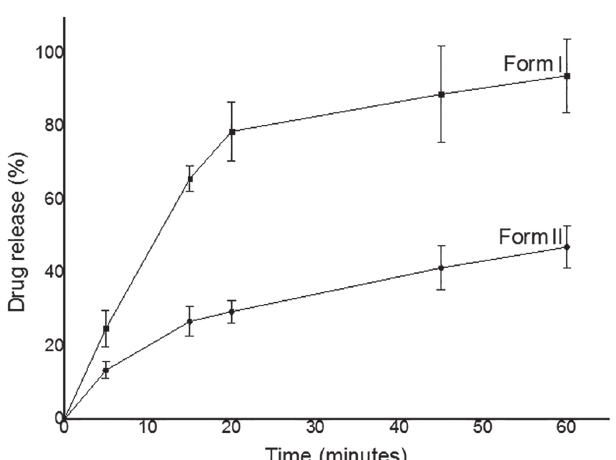
FIGURE 7 - Dissolution profiles of tablets containing tibolone forms I and II. Dissolution medium: 500 mL of 0.25% w/v solution of sodium lauryl sulfate at 37 °C; stirring apparatus: paddle at 50 rpm. Six tablets were assayed for each batch. Error bars represent standard deviations.